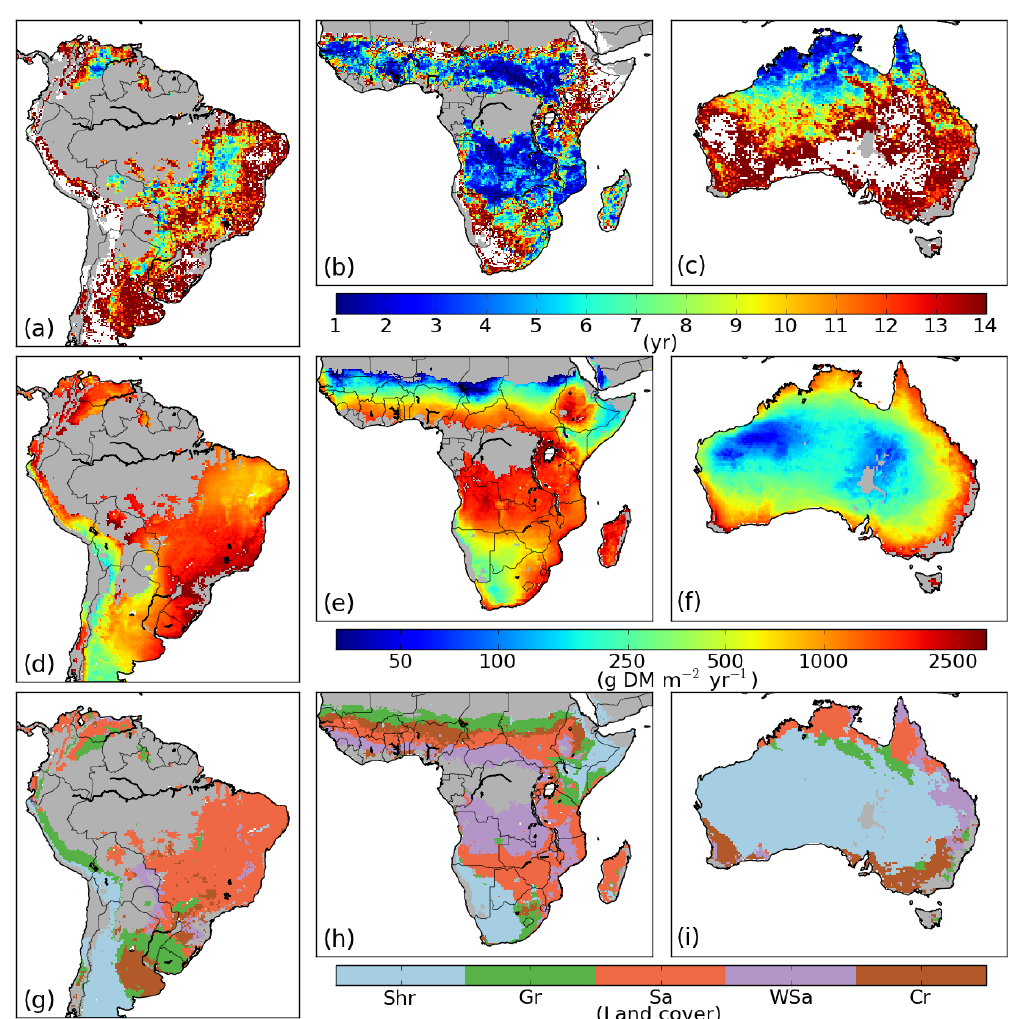
Figure A1. Spatial distribution of parameters affecting fuel consumption dynamics. (a–c) Fire return periods for South America, Sub-Saharan Africa and Australia, respectively; (d–f) net primary productivity for South America, Sub-Saharan Africa and Australia, respectively; and (g–i) dominant land cover type for South America, Sub-Saharan Africa and Australia, respectively. Grid cells with dominant land cover “forest” or “bare or sparsely vegetated” were excluded from our analysis and are masked grey, while water is shown in white. Abbreviations of land cover type stand for cropland (Cr), woody savanna (WSa), savanna (Sa), grassland (Gr) and shrubland